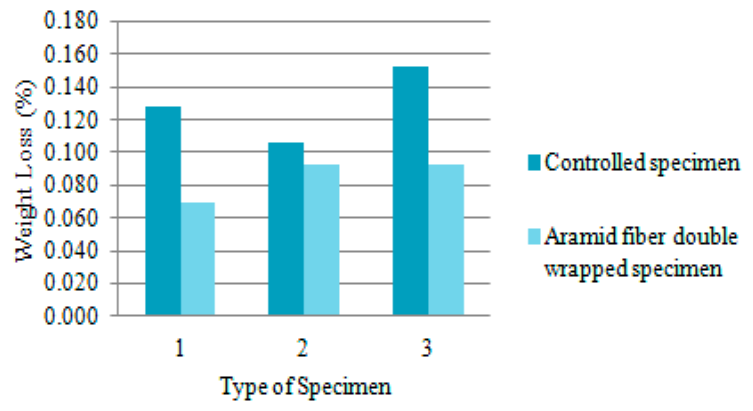
Figure 7. Compressive strength at 200 °C—1 h.